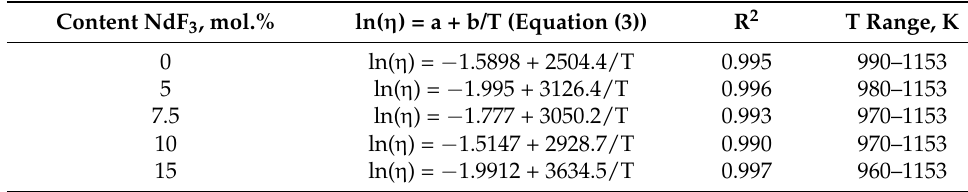
Table 2. Temperature dependence equations for (NaF - KF) eut - NdF 3 melts. Content NdF 3 , mol.%